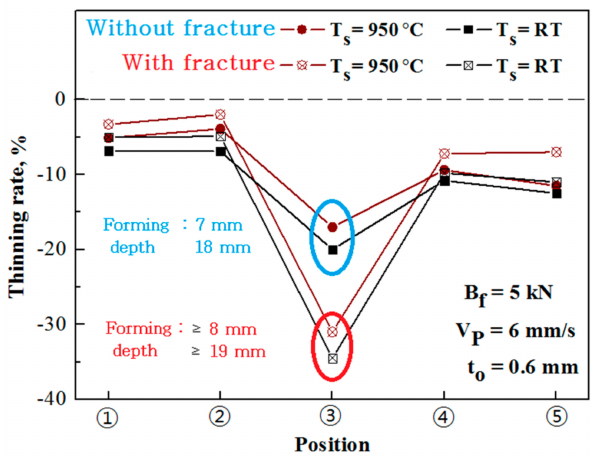
Figure 9. Thinning rate at each position for deep drawing samples with and without fracture.